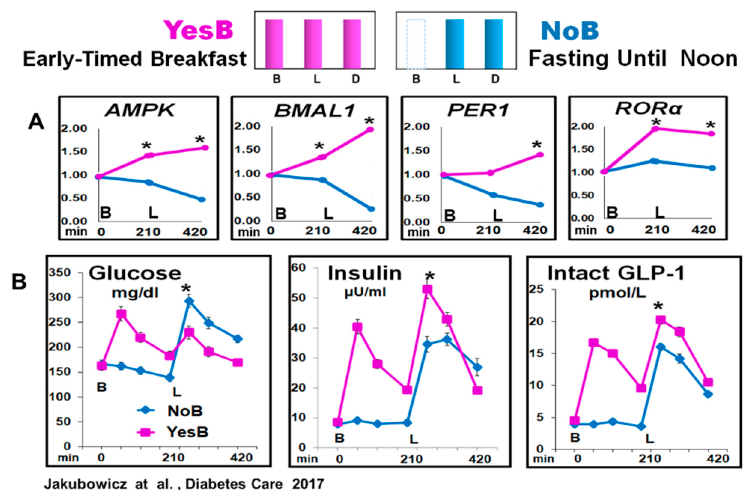
Figure 5. Clock Genes (AMPK, BMAL1, PER1 and ROR α ) mRNA expression and glucose, insulin, and intact GLP-1 blood levels, at fasting, before lunch and after lunch in YesB and NoB day in T2D. ( A ) Clock gene expression: Blood samples were collected in YesB (purple) and NoB day (blue), at fasting (time point 0 min), before lunch (time point 210 min), and 3.5 h after lunch (time point 420 min). Asterisks denote statistical differences ( p < 0.05) between time points 210- and 420 min. B: Line charts of glucose, insulin, and intact GLP-1 postprandial responses in YesB and NoB days. Breakfast ( B ) was given to the YesB group at time point 0. Lunch (L) was given to both groups at a time point of 210 min. Asterisks denote statistical differences between YesB and NoB at a specific time point. Data are means ± SE. “Reproduced and adapted with permission” [22].